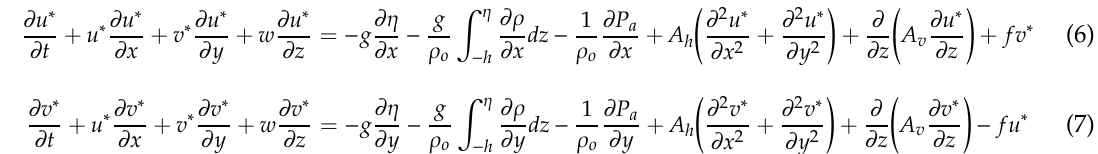
and v ∗ are the face normal j , k j , k